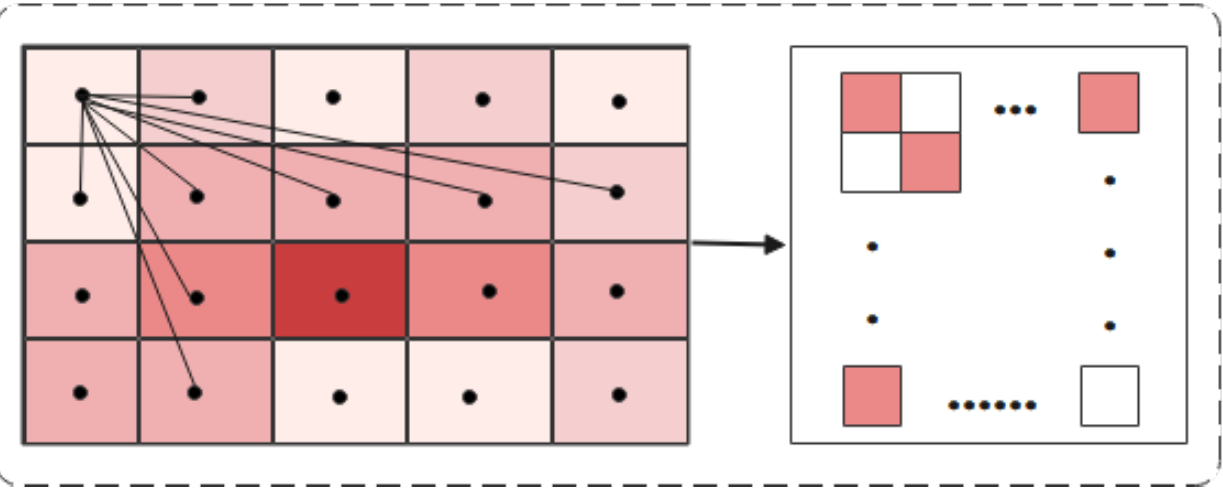
Figure 3. Construction of adjacency matrix based on node distance.